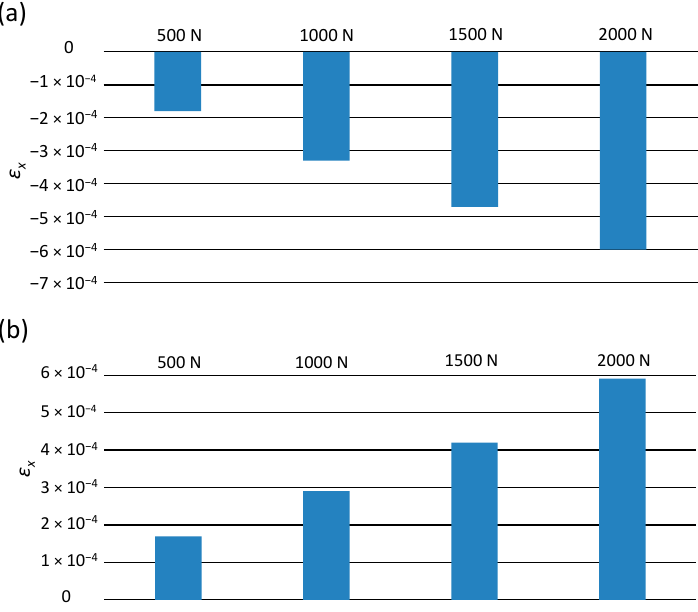
Figure 7. The maximum values of longitudinal deformations ε x : ( a ) on the top surface of the pipes, ( b ) on the bottom surface of the pipes.